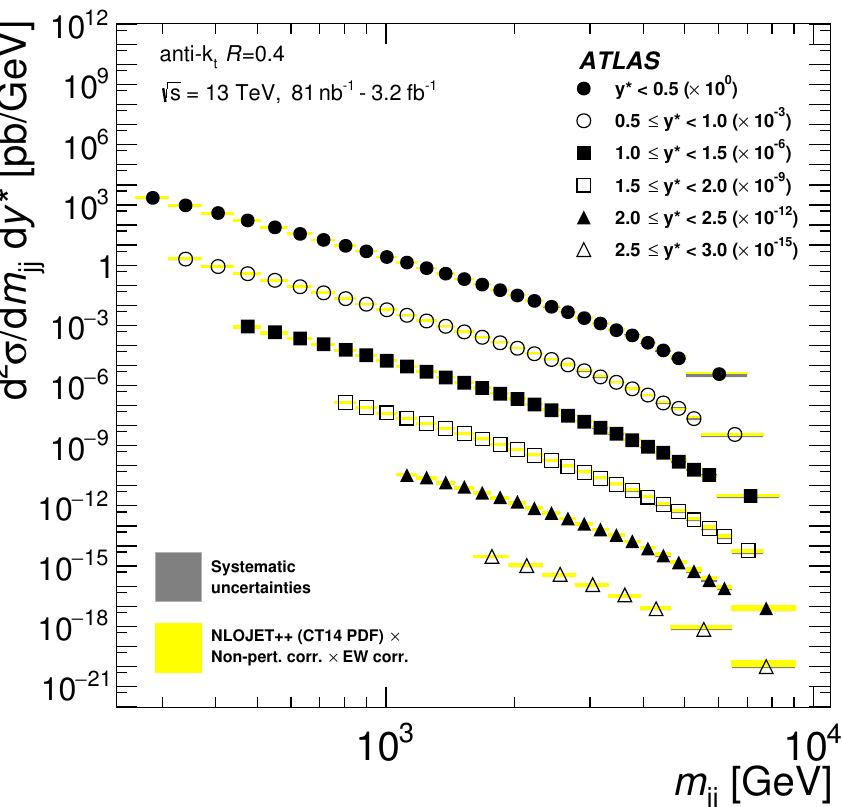
Figure 6 . Dijet cross-sections as a function of m jj and y (cid:3) , for anti- k t jets with R = 0 : 4. The statistical uncertainties are smaller than the size of the symbols used to plot the cross-section values. The dark gray shaded areas indicate the experimental systematic uncertainties. The data are compared to NLO pQCD predictions calculated using NLOJET++ with p max QCD scale and the CT14 NLO PDF set, to which non-perturbative and electroweak corrections are applied. The light gray (yellow in the online version) shaded areas indicate the predictions with their uncertainties. In most m jj bins the experimental systematic uncertainty is smaller than the theory uncertainties and is therefore not